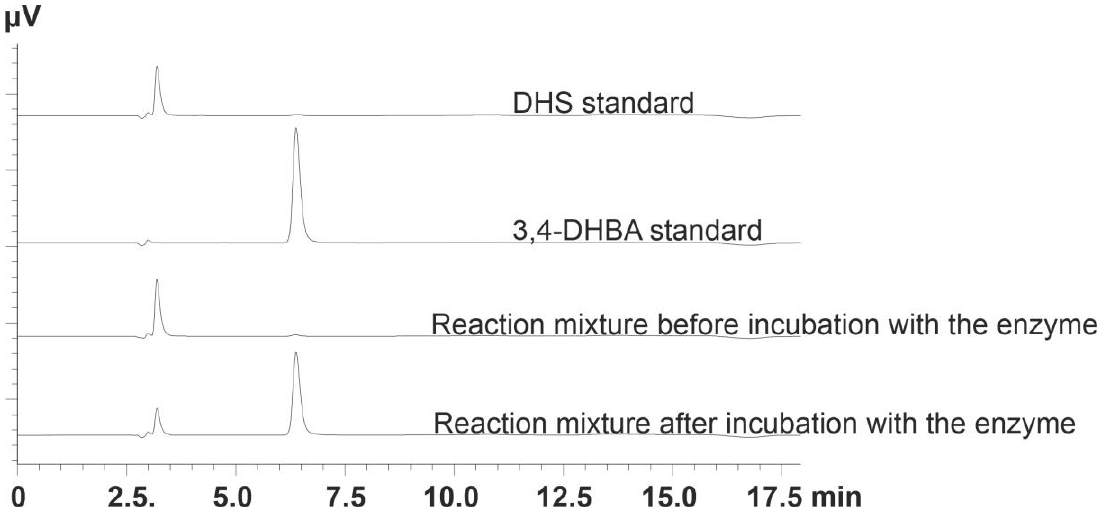
Figure 2. HPLC analysis of the reaction mixtures before and after incubation with the DSDs.